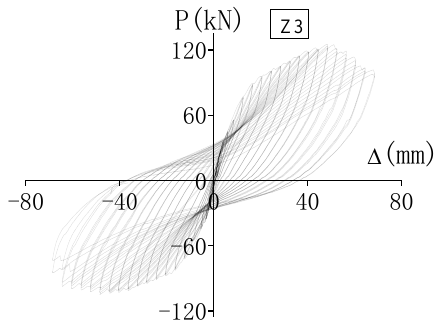
Figure 13. Hysteretic curve Z3 ( ρ = 8%, one layer).